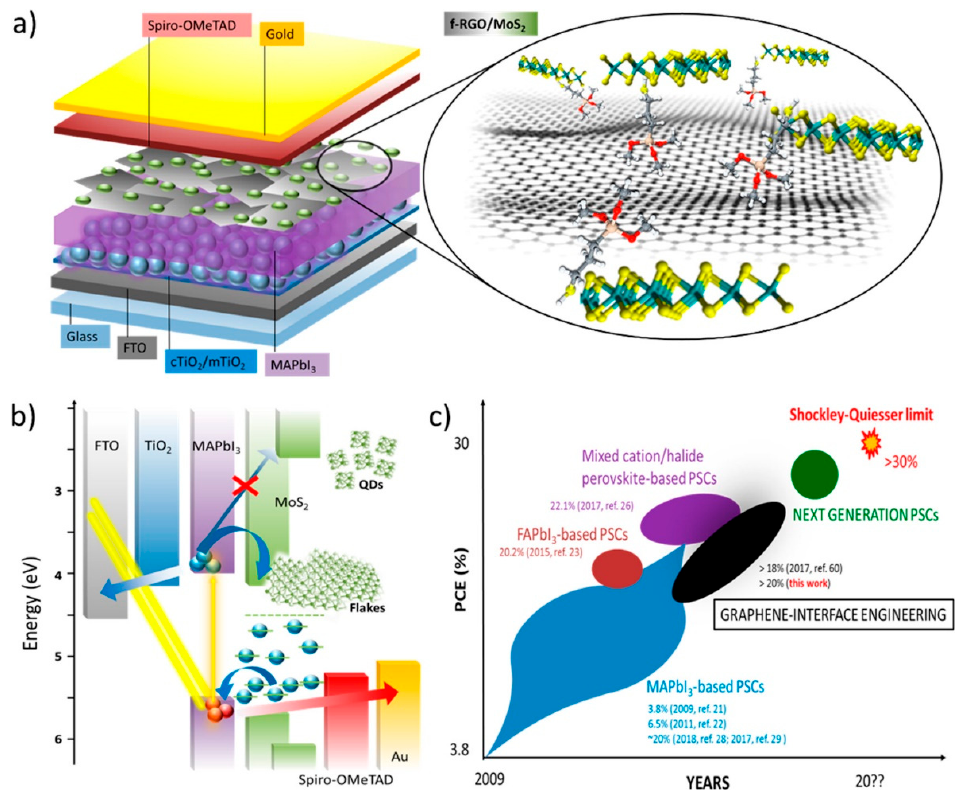
Figure 15. ( a ) Illustration of the mesoscopic MAPbI 3 -based PSC exploiting MoS 2 QDs:f-RGO hybrids as both the hole transport layer and the active buffer layer. ( b ) Energy band diagram of the materials used in the assembled sell. ( c ) Current and predicted PCE evolution for PSCs, demonstrating the synergistic potential of graphene interface engineering. Reproduced with permission from [82]. American Chemical Society, 2018.